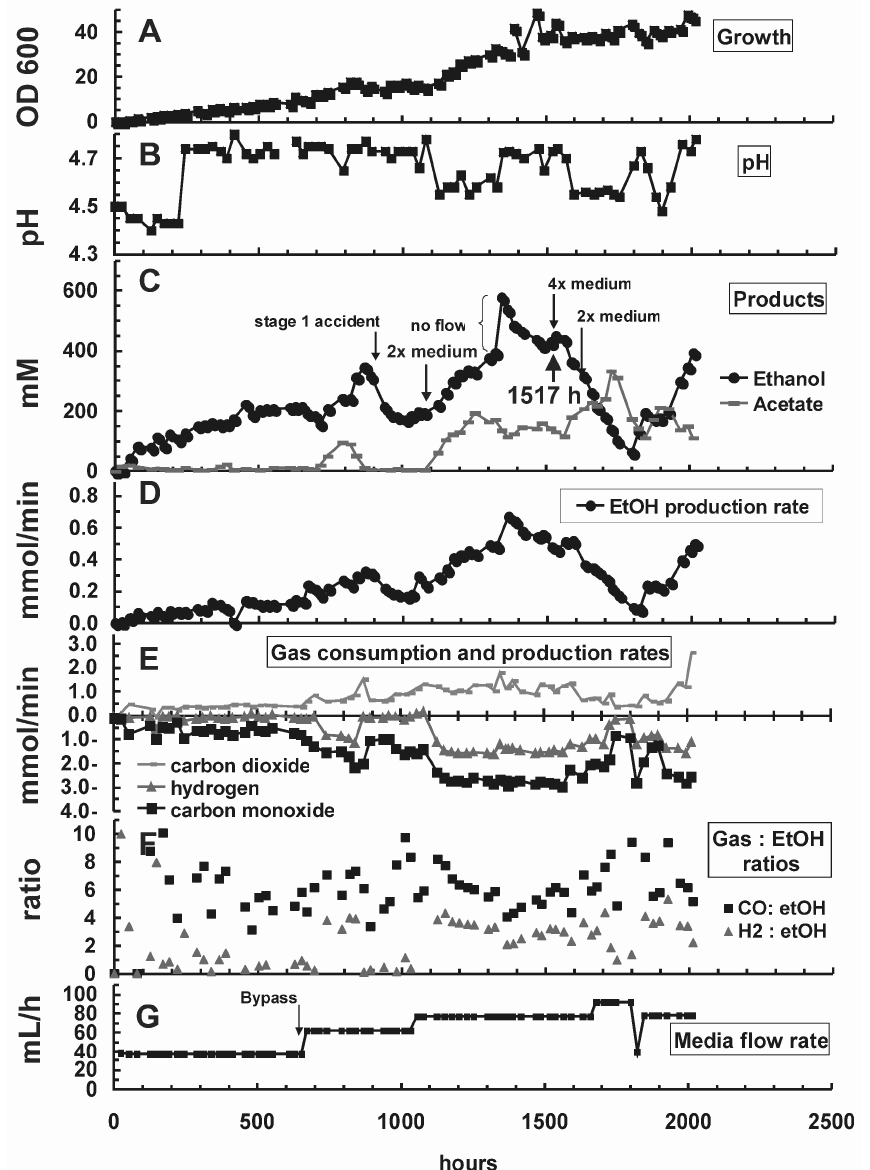
Figure 2. Performance of stage two during continuous operation for 2014 h (83 days). Shown are the data for: ( A ) growth (OD ); ( B ) pH value; ( C ) concentration of the 600 fermentation products ethanol and acetate in mM; ( D ) the average daily ethanol production rate (mmol/min); ( E ) the average daily rates of consumption (mmol/min) for carbon monoxide and hydrogen and for production of carbon dioxide; ( F ) the average daily molar ratios of carbon monoxide and hydrogen consumed vs . ethanol produced; and ( G ) the average total daily feed rate of media (total media flow, mL/h). Arrows with comments indicate changes made to the system, which is explained in more detail in Table 1 and in the text. 1517 h is the timepoint at which stable performance at optimized conditions was achieved, and where performance data were taken for Table